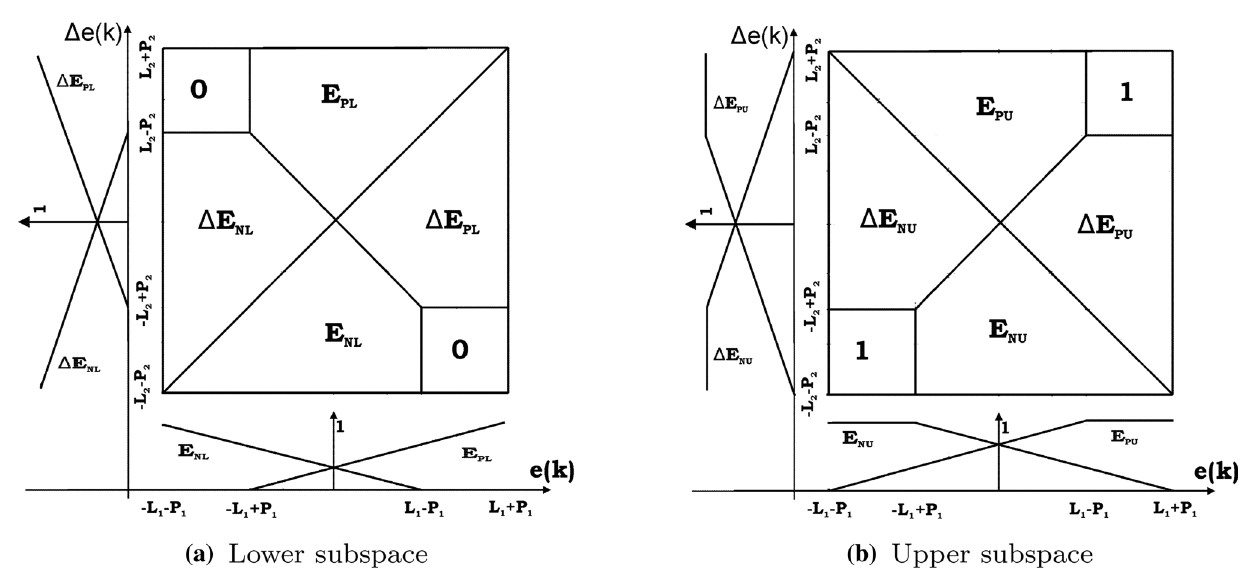
Fig. 4 Lower and upper subspaces with respect to Rule